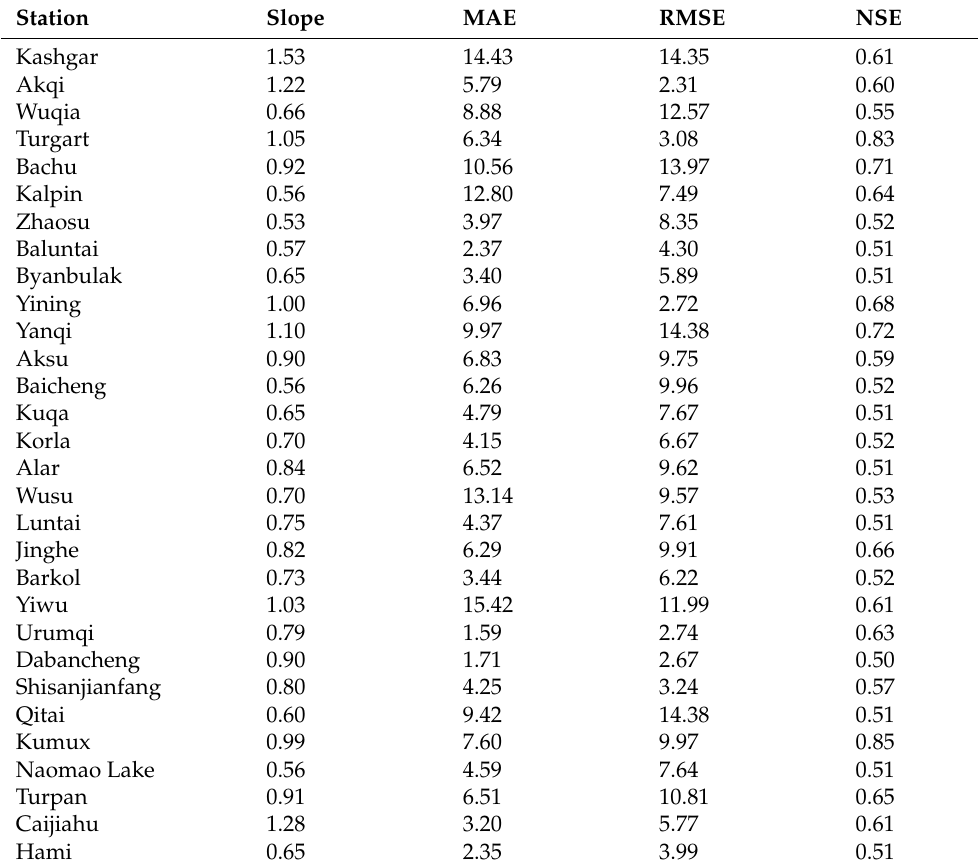
Table 3. Accuracy test of downscaled dataset.